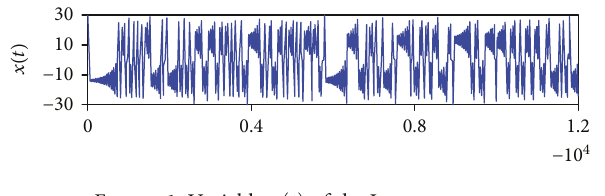
Figure 1: Variable x t of the Lorenz system.